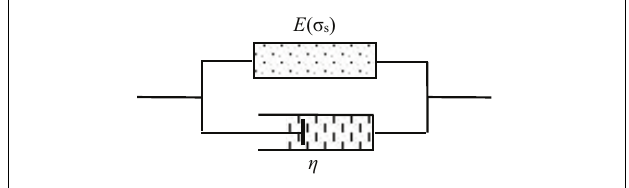
FIGURE 2 | Simplified mechanical model of a